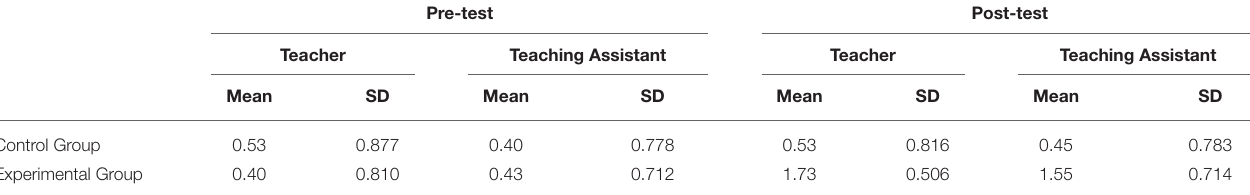
TABLE 5 | Descriptive statistics for teachers and teaching assistants from both